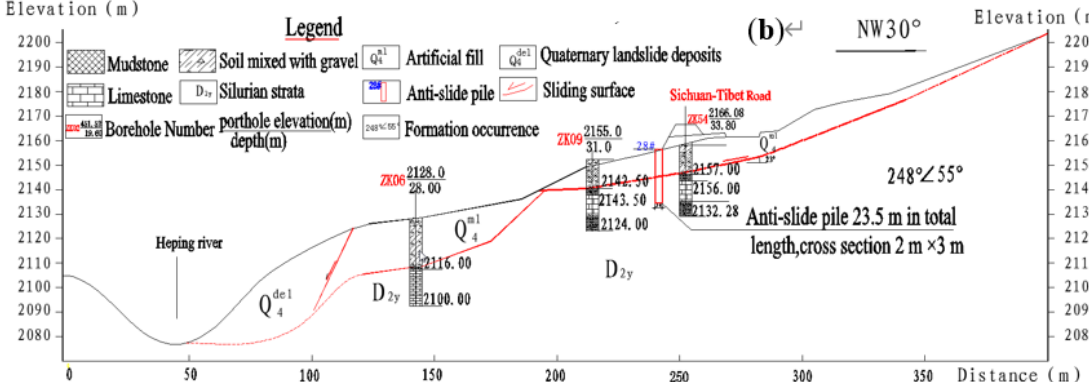
Figure 2. Geology conditions pertaining to the Zhenzilin landslide obtained via engineering geological survey: ( a ) a geological map of the Zhenzilin landslide; ( b ) a cross- section AA′ of the Zhenzilin landslide.